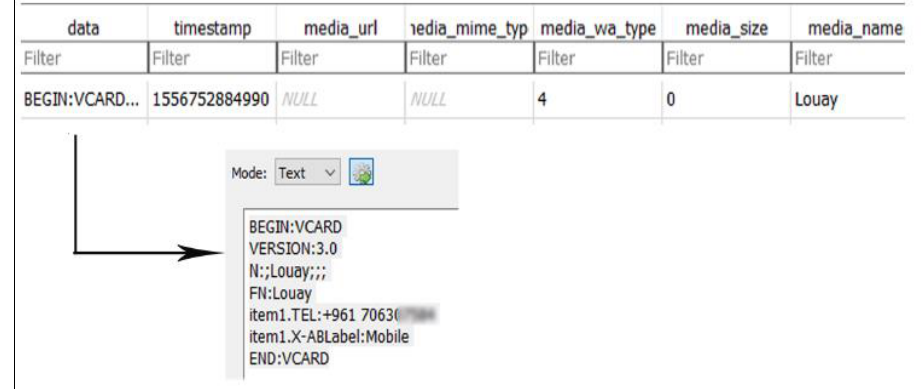
Figure 16. Contact card